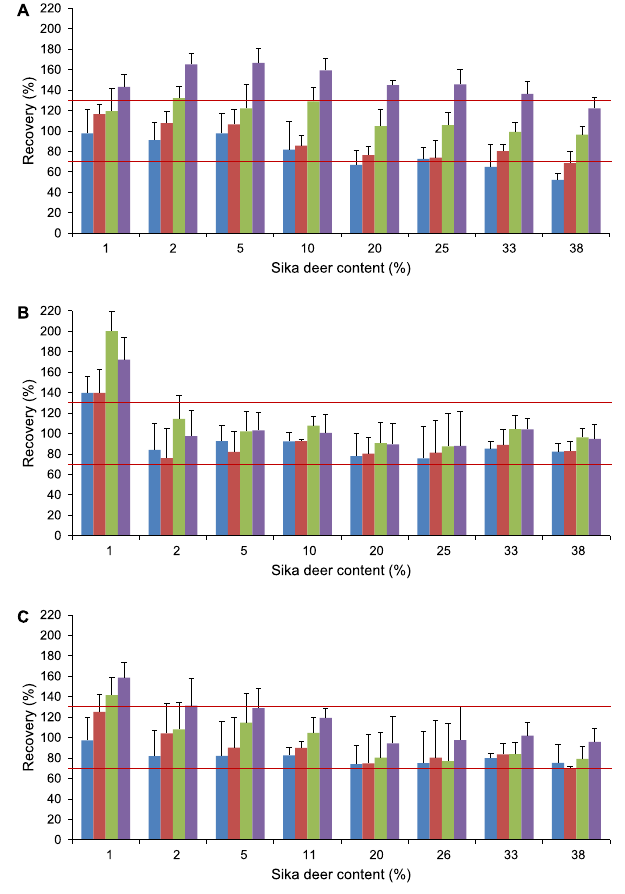
Figure 4. Mean recovery and RSD obtained for ( A ) DNA mixtures, ( B ) meat extract mixtures and ( C ) meat mixtures. Calibration mixtures contained 5% (blue columns), 10% (red columns), 25% (green columns) and 50% (violet columns) sika deer. Red horizontal lines indicate recoveries between 70% and